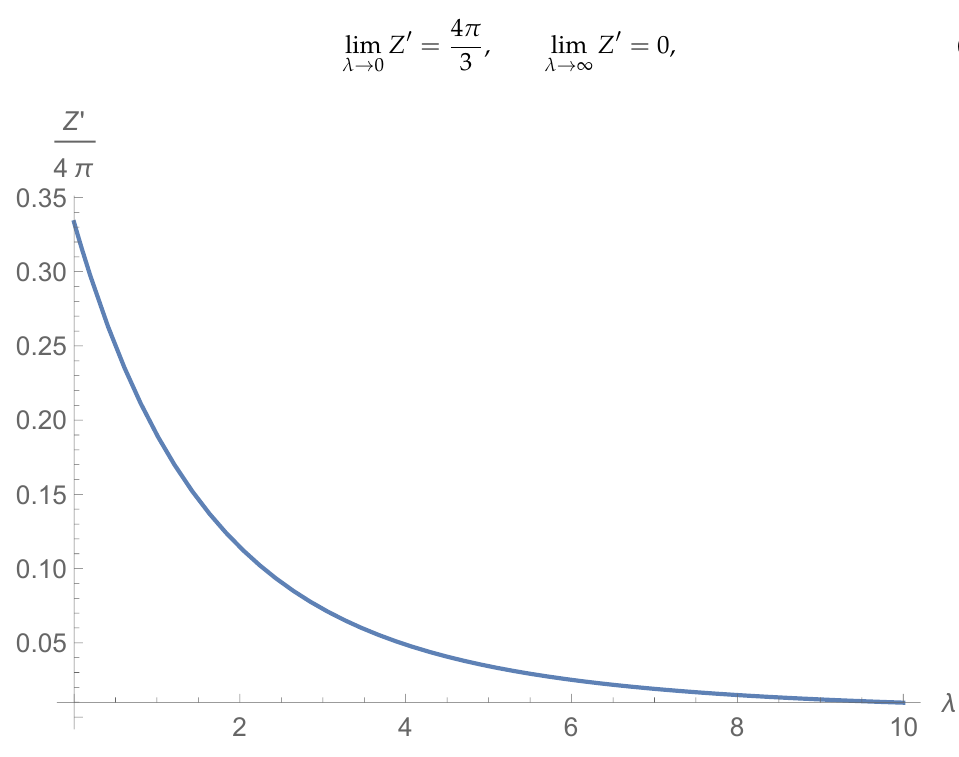
Figure 16. Partition function for a free Euclidean